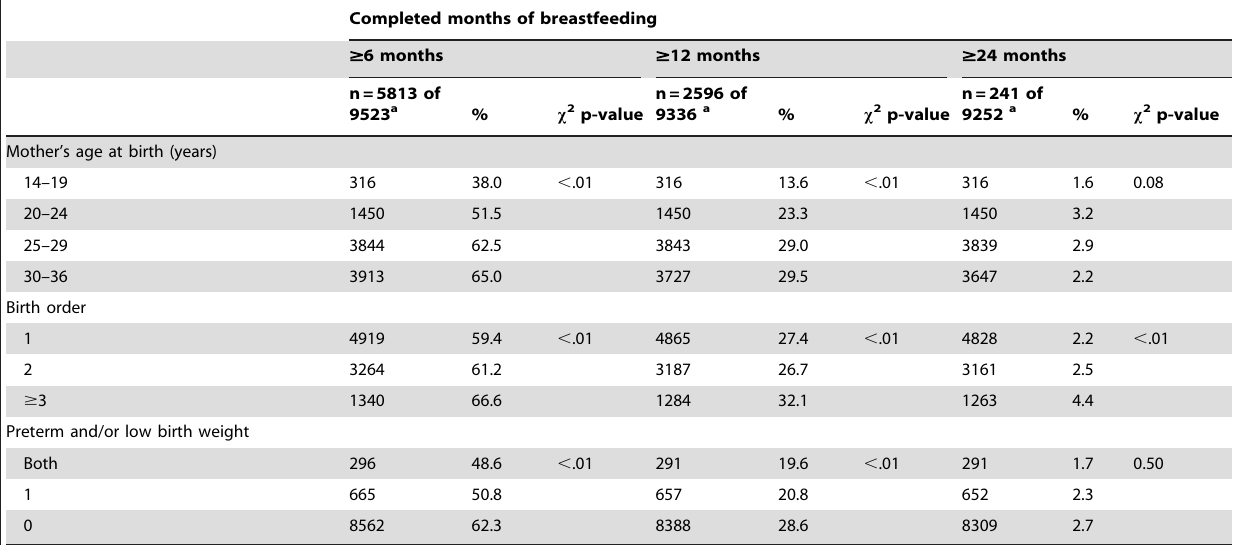
Table 1. Characteristics of children by completed months of breastfeeding in line with the national and international duration